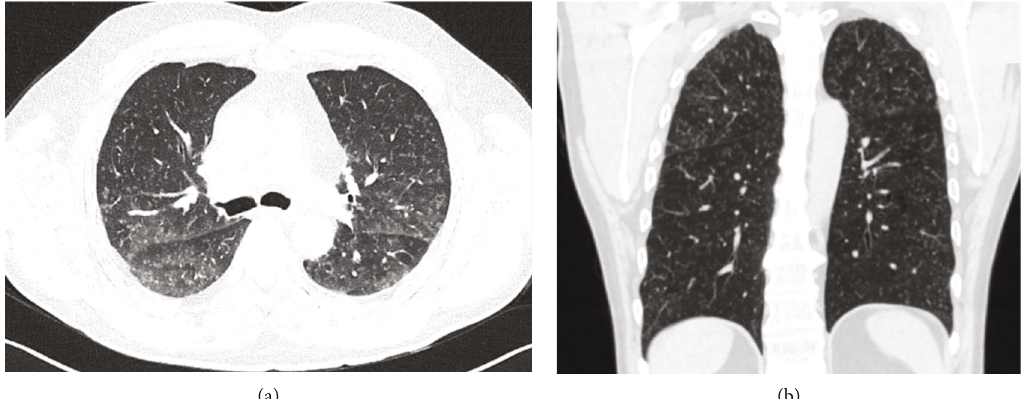
Figure 1: High-resolution computed tomography (HRCT) images (a, b) demonstrate di ff use, multiple nodular lesions in the parenchyma of both lungs.